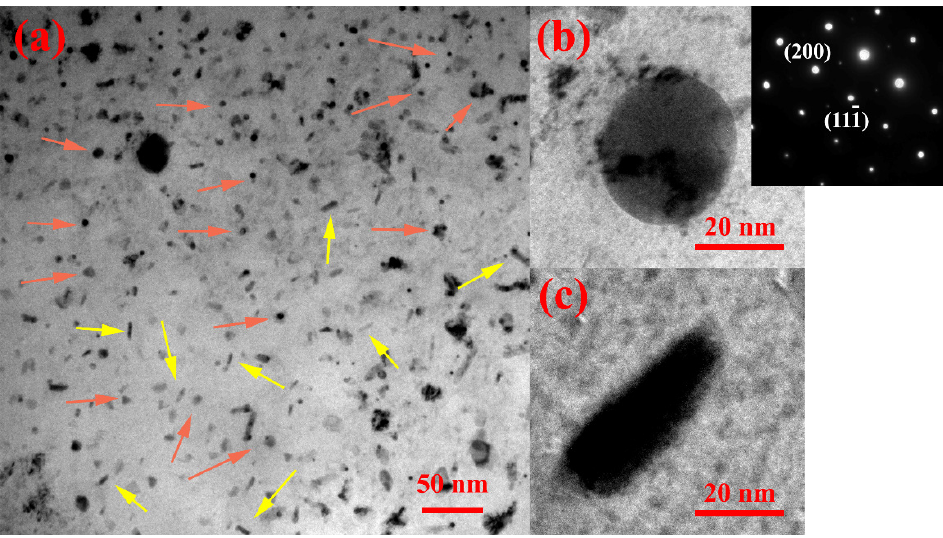
Figure 11. HR-TEM micrograph of the sampleMD50. ( a ) distribution of the spherical and rod shaped precipitates, ( b ) higher magnification of the spherical precipitate ( c ) higher magnification of the rod precipitate.